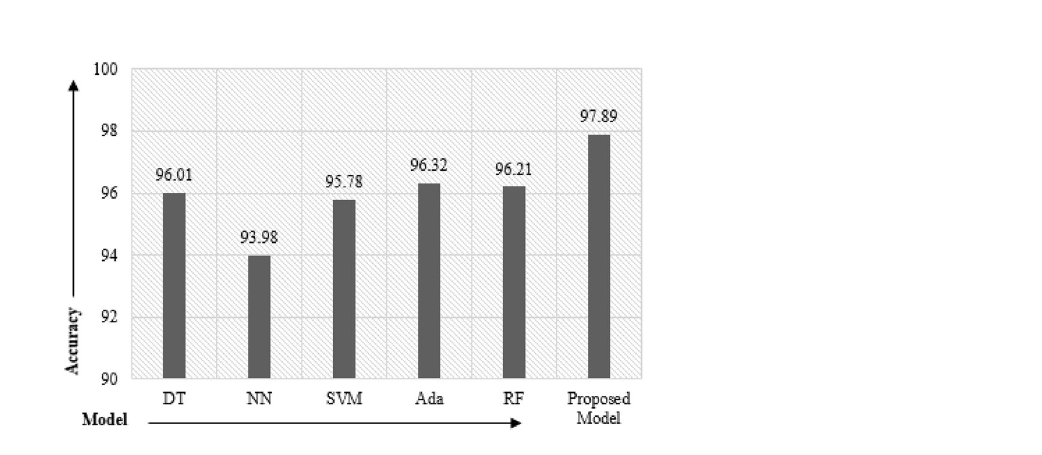
Figure 7. Performance comparison bar